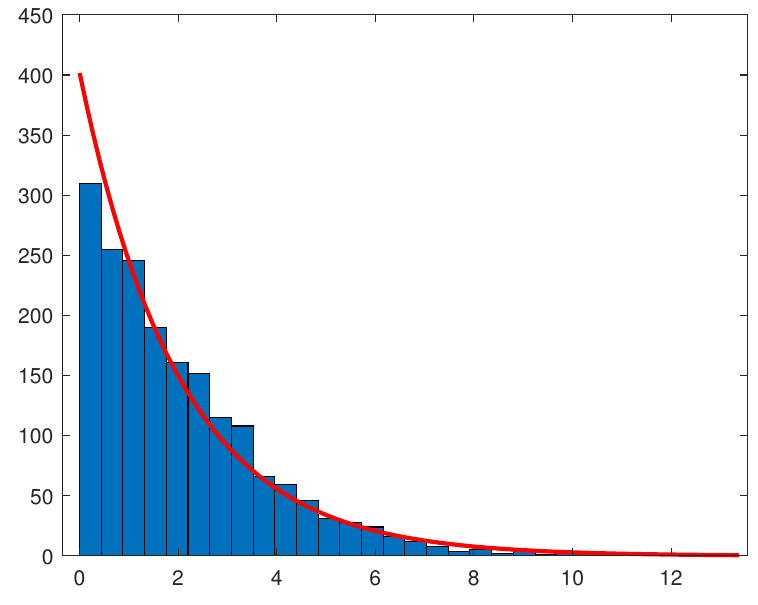
Figure 4. Exponential fit of temperature distribution—tail below 10%